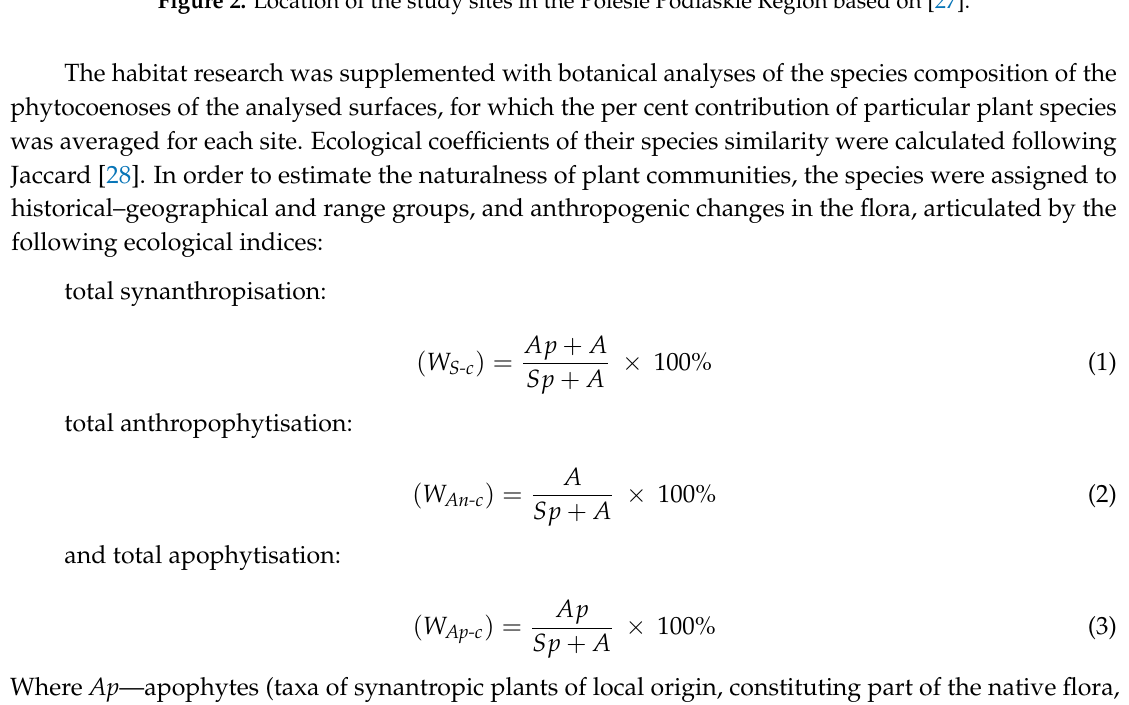
Figure 2. Location of the study sites in the Polesie Podlaskie Region based on [ 27 ].